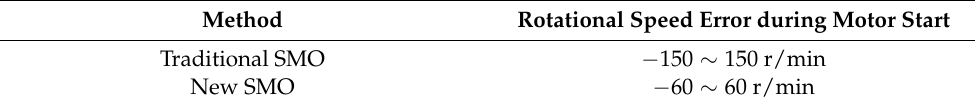
Table 7. Comparison of experimental results of rotational speed error.